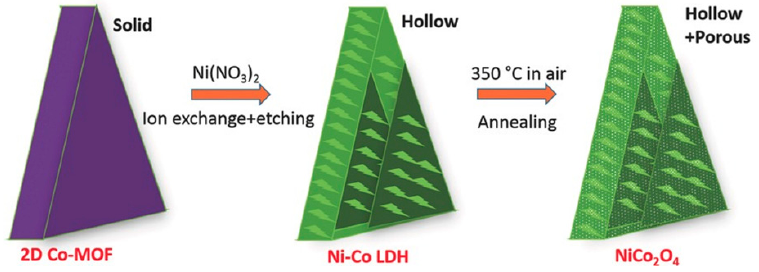
Figure 18. Route to uniform hollow NiCo 2 O 4 nanostructure from 2D Co-MOF solid nanowall precursors. Reproduced from [54], with permission from John Wiley and Sons, copyright 2017.